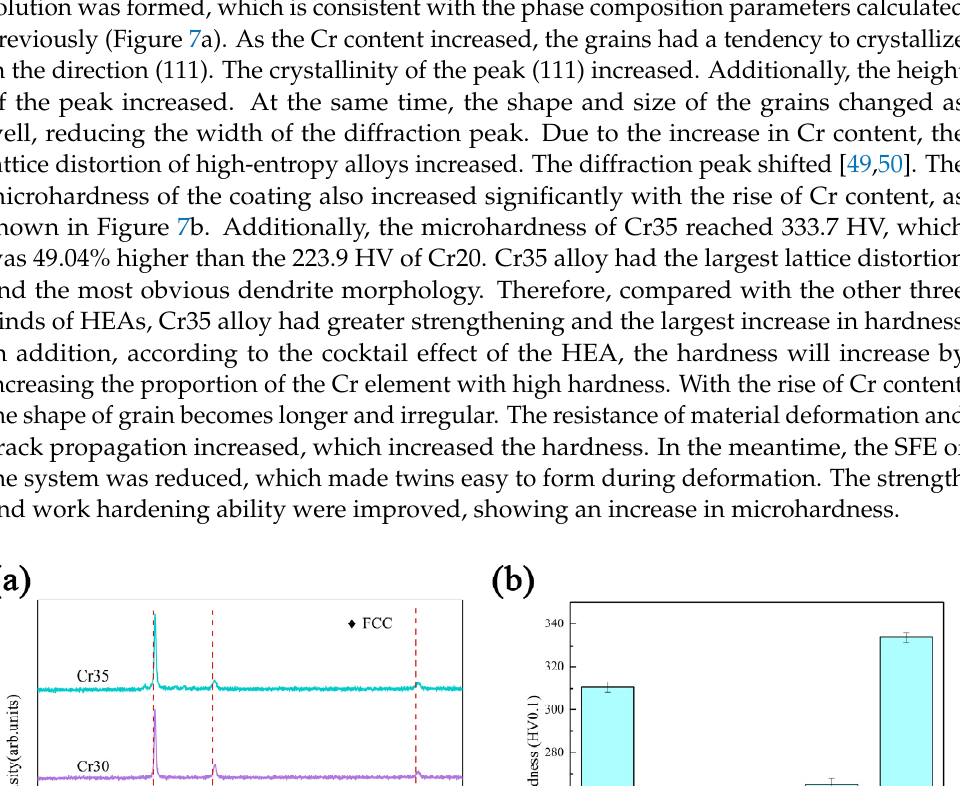
Figure 7. XRD patterns of the HEA coatings ( a ) and microhardness of substrate and coatings ( b ).